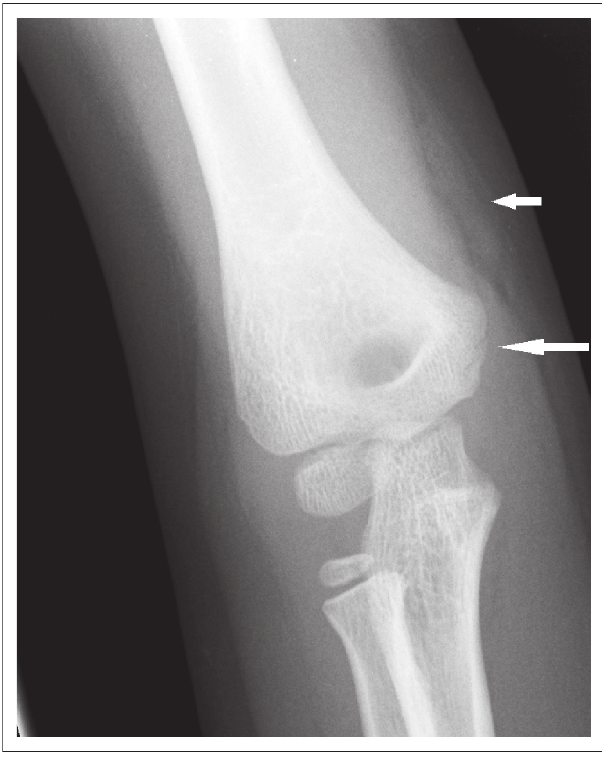
FIGURE 12: Left medial condyle fracture in a 4 year old. Note the medial soft tissue swelling (short arrow) and the subtle fracture line involving the medial condyle (long arrow).